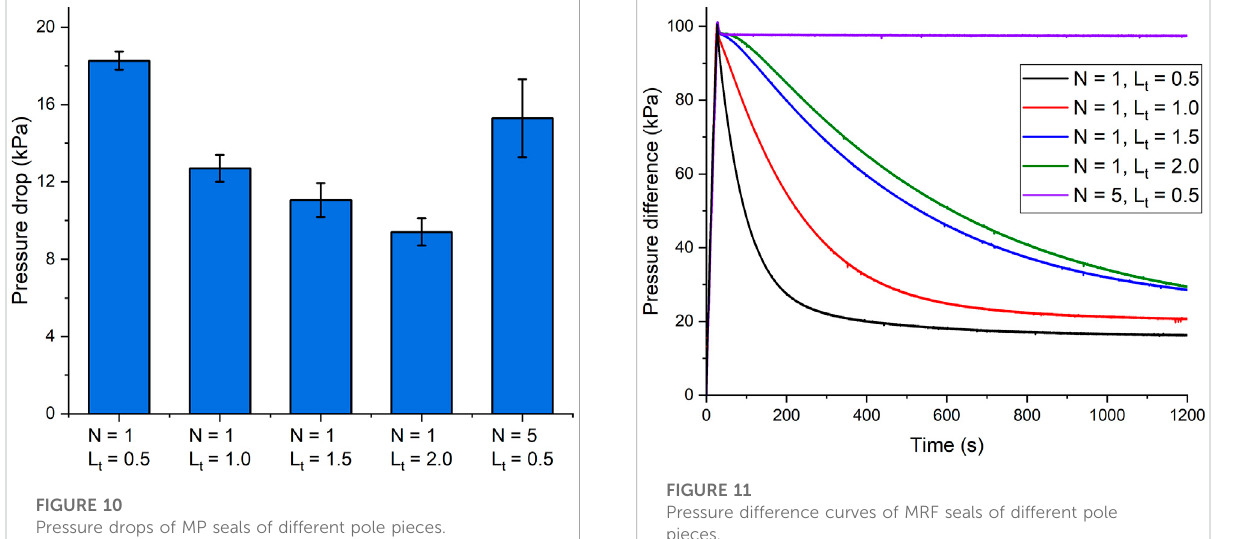
FIGURE 11 Pressure difference curves of MRF seals of different pole